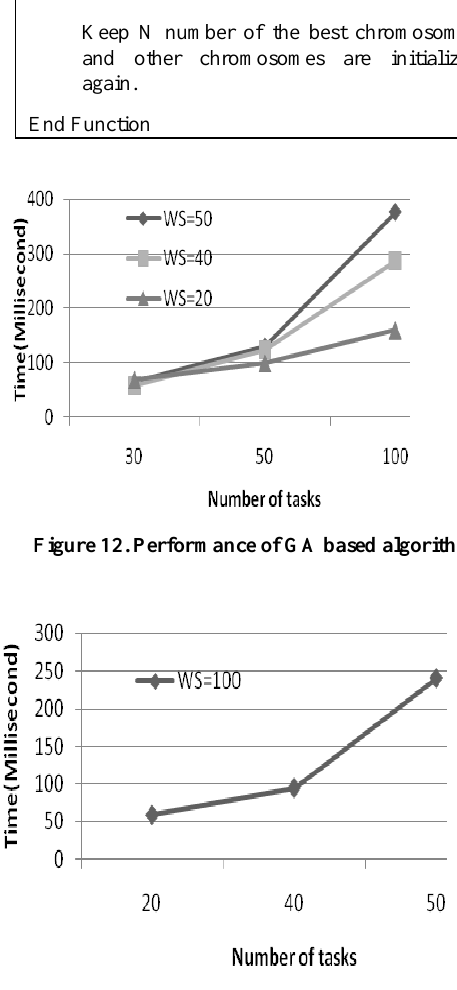
Figure 13. Performance of GA based algorithm with 100 tasks.